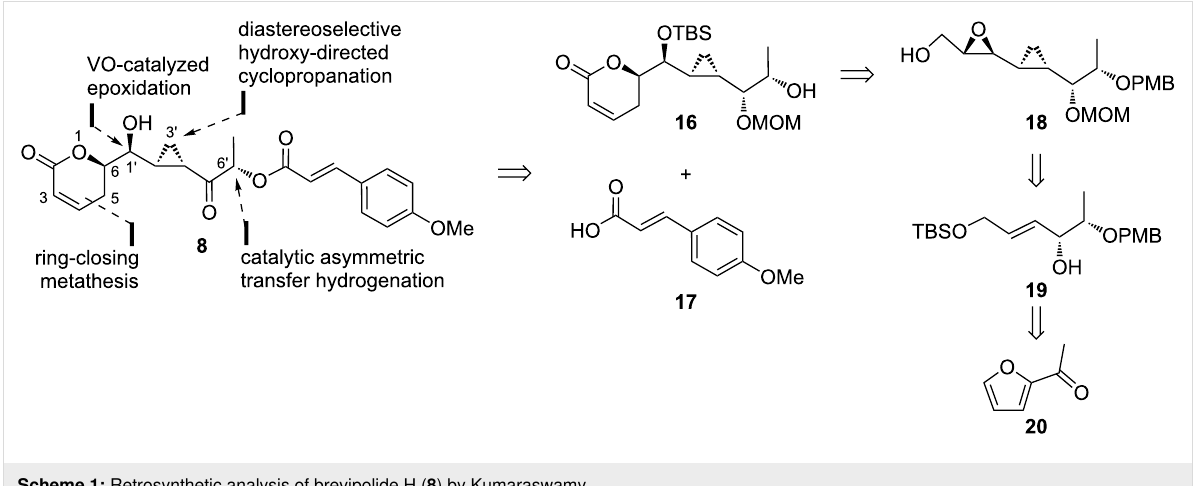
Scheme 1: Retrosynthetic analysis of brevipolide H ( 8 ) by